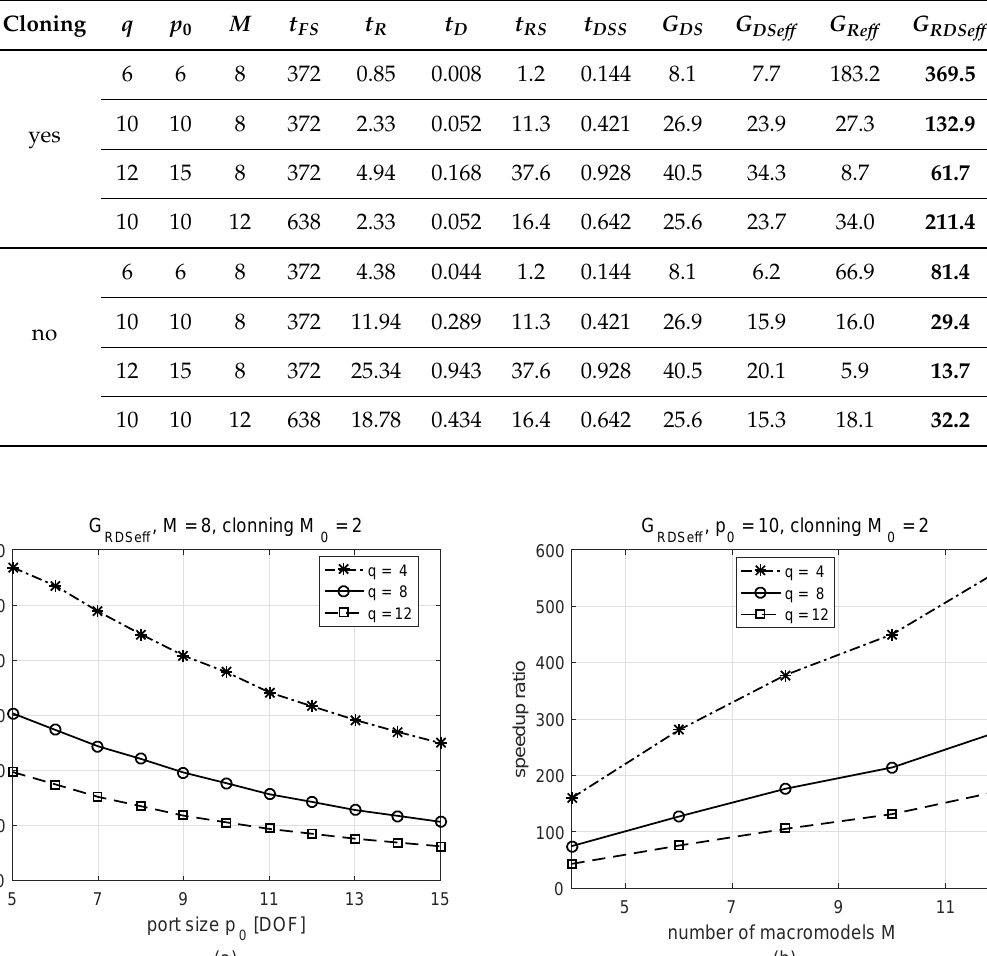
Table 1. The times of MOR, diagonalization and solution of the systems of equations (in seconds) along with MOR and diagonalization gains for selected combinations of q , p 0 , M and two options of cloning.